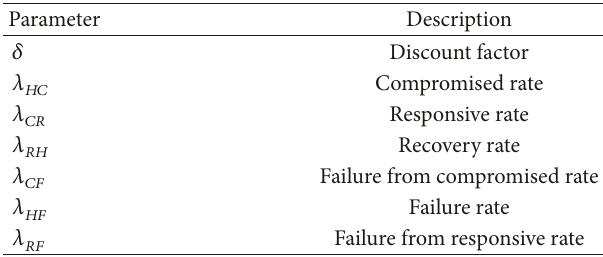
Table 1: The parameters in models.